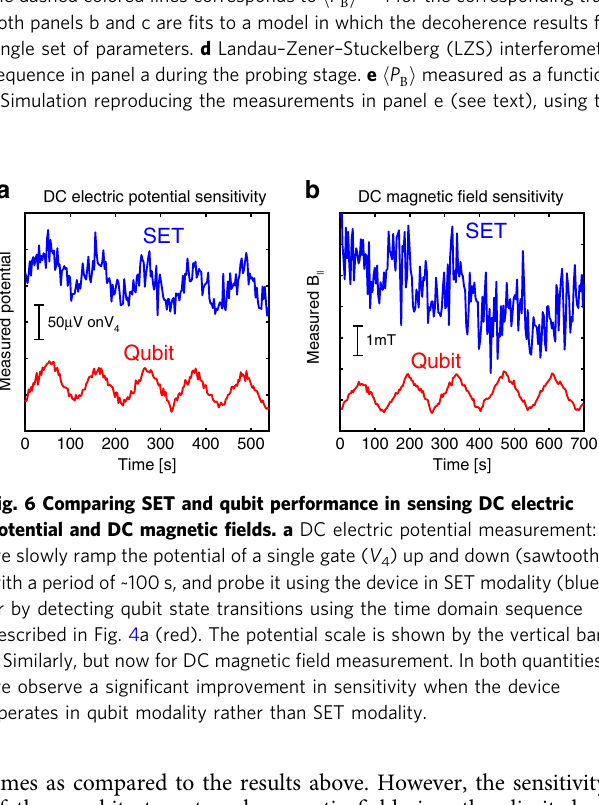
h i as a function of Δ V = V − V τ G G BD , for different probe . Curves are offseted for clarity, and B Δ V h i = 1 for the corresponding traces. c Measured P h i as a function of τ probe for few values of G . Solid lines in B B h i measured as a function of Δ V A f = 0.7 GHz, exhibiting the LZS interference pattern. G and LZS , with LZS B